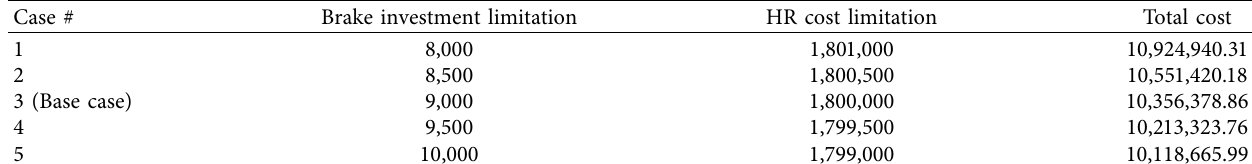
Figure 3: HR cost sensitivity analysis. Table 6: HR cost and brake investment limitations trade-off.